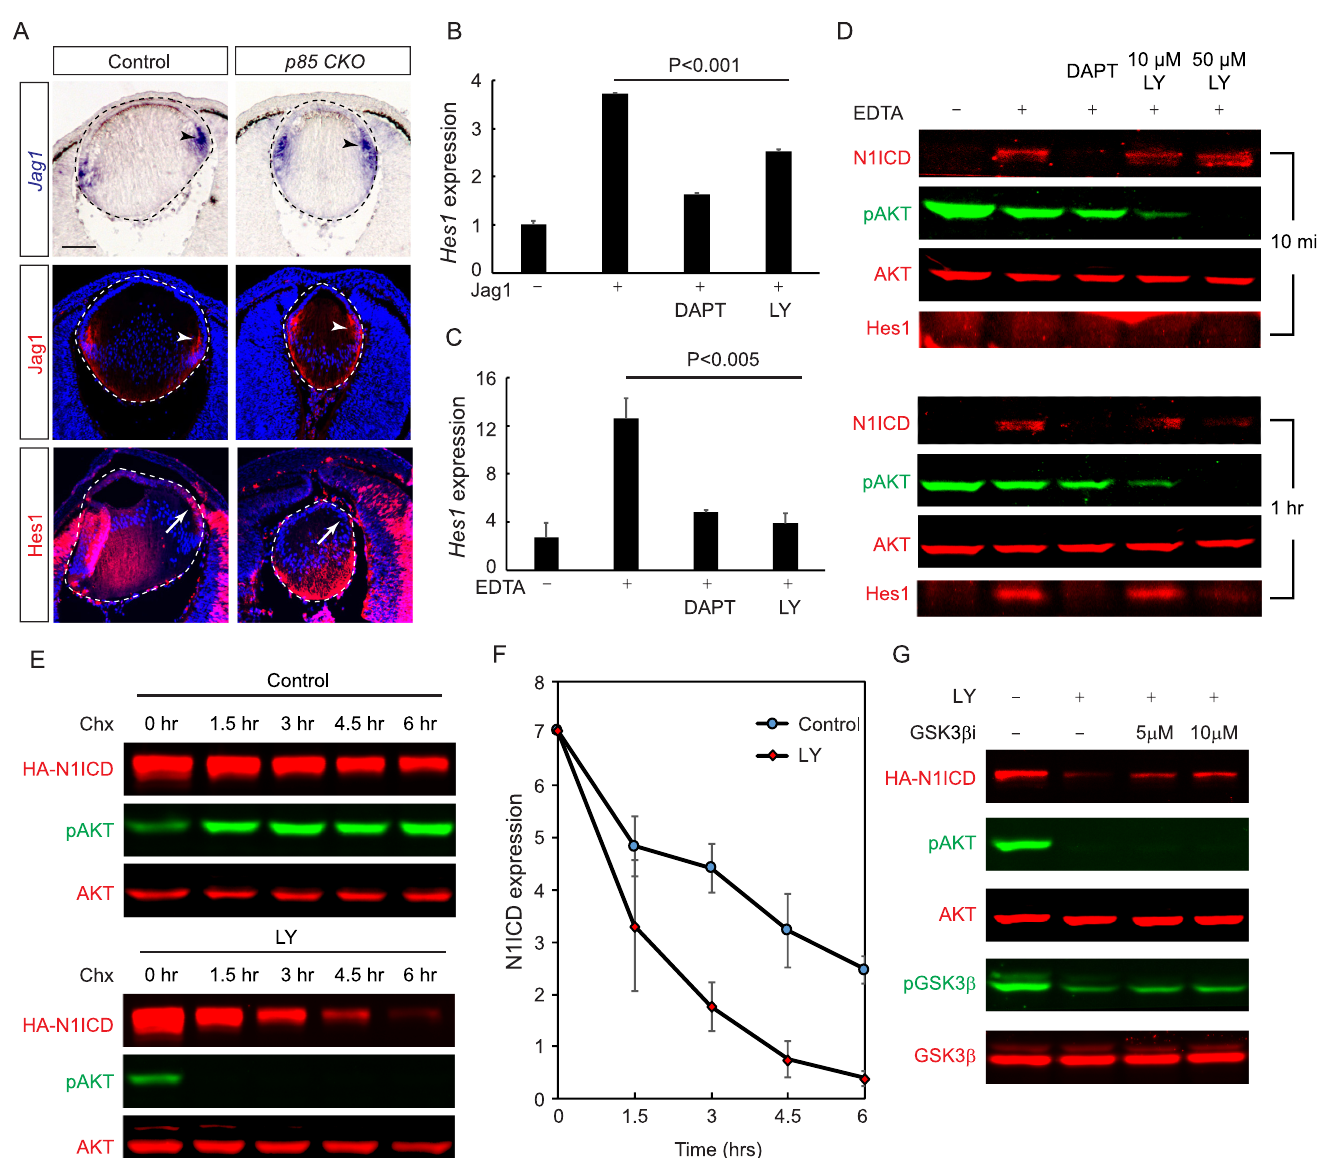
Fig 5. Loss of PI3K activity reduces Notch signaling by decreasing N1ICD stability. (A) The p85 CKO lens displayed normal expression levels of Jag1 in the nascent lens fiber cells (arrowheads) but a sharp reduction of Hes1 in the lens progenitor cells (arrows). (B) Both the Notch signaling inhibitor DAPT and the PI3K inhibitor LY294002 reduced Jag1-induced Hes1 expression in immortalized lens cells. (C) Hes1 expression induced by EDTA in lens cell culture was also suppressed by DAPT and LY294002. (D) EDTA induced N1ICD in lens cells at 10 minutes and Hes1 by 1 hour, and both were inhibited by DAPT. In contrast, increasing concentration of LY294002 suppressed AKT phosphorylation, and it affected N1ICD level after 1 hour. (E) After treatment of Chx to stop protein translation in lens cells, there was a slow decay of exogenously expressed HA-tagged rat-N1ICD, which was greatly accelerated in the presence of 50 μ M LY294002. (F) Quantification of the HA-N1ICD level normalized with AKT expression after three independent experiments. (G) GSK3 β i CHIR99021 partially stabilized HA-N1ICD after LY294002 treatment. The numerical data used in panels B, C, and F are included in S1 Data. AKT, Protein kinase B; Chx, cycloheximide; DAPT, N-[N-(3,5-Difluorophenacetyl)-L-alanyl]-S- phenylglycine t-butyl ester; GSK3 β , Glycogen Synthase Kinase 3 β ; GSK3 β i, GSK3 β inhibitor; HA, Human influenza hemagglutinin; Hes1, Hes Family BHLH Transcription Factor 1; Jag1, Jagged 1; KO, knockout; N1ICD, Notch1 intracellular domain; pAKT, phsopho-AKT; PI3K, Phosphoinositide 3-kinase; pGSK3 β , phospho-GSK3 β ; p85 CKO , Le-Cre;p85 α f/f ;p85 β KO/KO